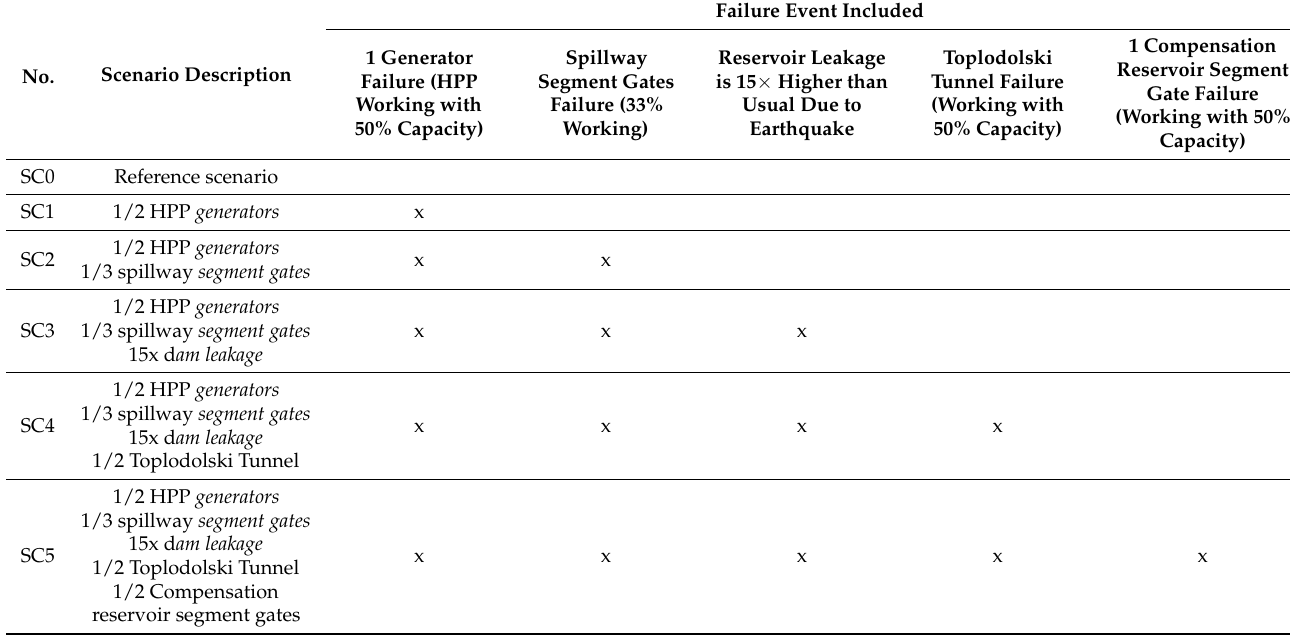
Table 4. Description of failure scenarios (SC) consisting of multi-failure